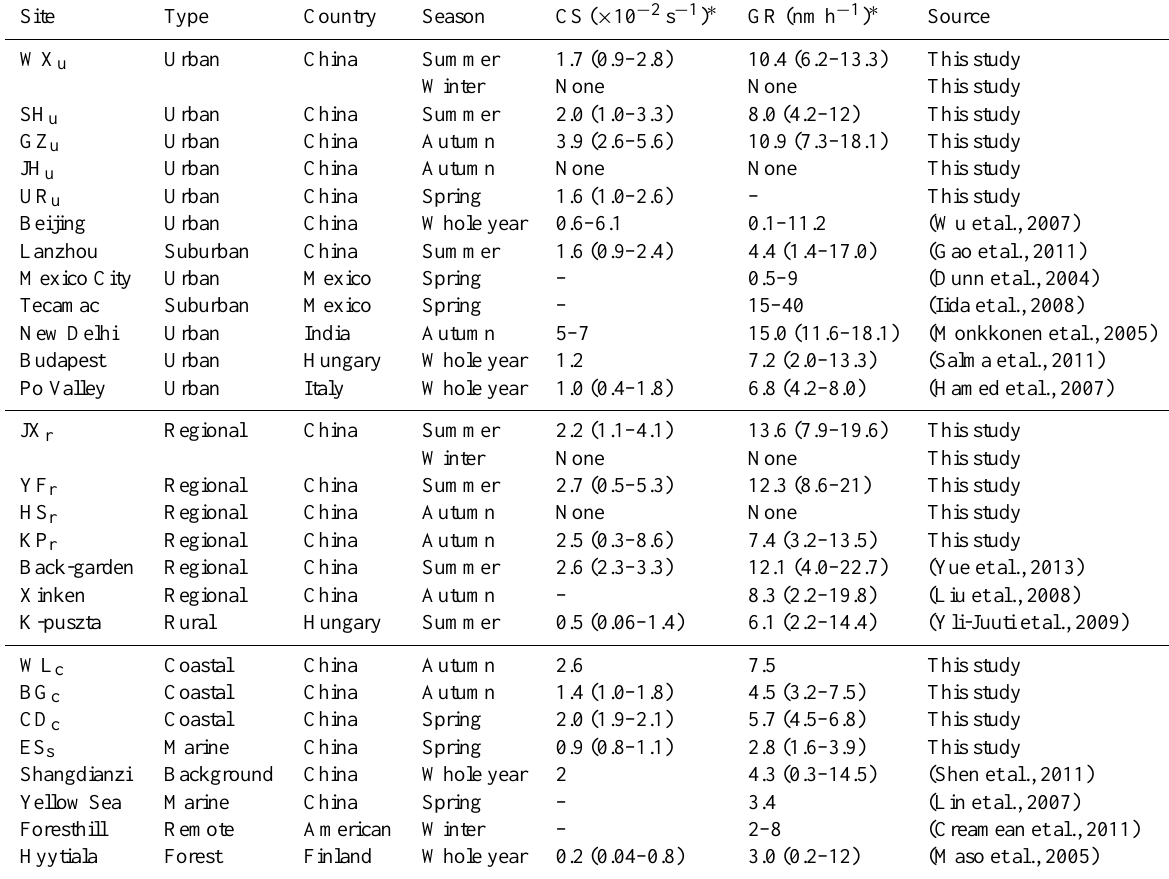
Table 3. Summary of parameters of NPF events at different sites.